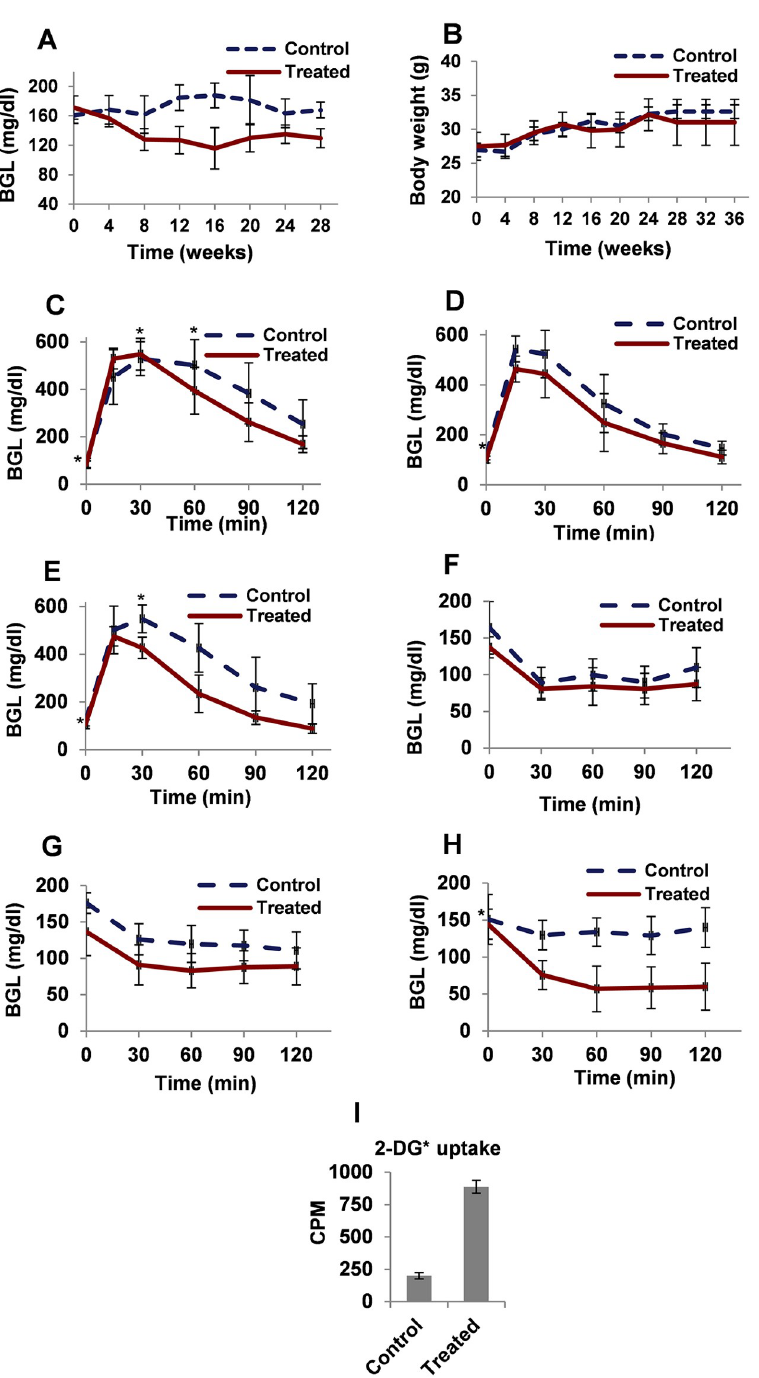
Fig 1. Increased glucose dispersal and insulin sensitivity in treated animals as compared to control ones without any significant change in the body weight. Fig 1A: PP BGL of the control and the treated animals. The data were analyzed by t-test, data represents mean ± S.D. n = 8, N = 2, p < 0.05. B: Body weight of the control and treated animals. The data were analyzed by t-test, data represents mean ± S.D. n = 8, N = 2, p > 0.1. Figs C-E: GTT of the control and the treated animals after 4 (Fig 1C), 16 (Fig 1D) and 32 (Fig 1E) weeks of treatment. Figs 1F-H: ITT of the control and the treated animals after 4 (Fig 1F), 16 (Fig 1G) and 32 (Fig 1H) weeks of treatment. The data were analyzed by t-test, data represents mean ± S.D. n = 8, N = 2, p < 0.05, � = p > 0.05. Fig I: Ex-vivo 2-DG � uptake in skeletal muscle of control and treated animals after 32 weeks of treatment. The data were analyzed by t-test, data represent mean ± S.D. of 3 independent experiments (n = 3), p < 0.05. J: Glycogen content assay in skeletal muscle of control and treated animals after 32 weeks of treatment. The data were analyzed by t-test, data represent mean ± S.D. of 3 independent experiments (n = 3), p <